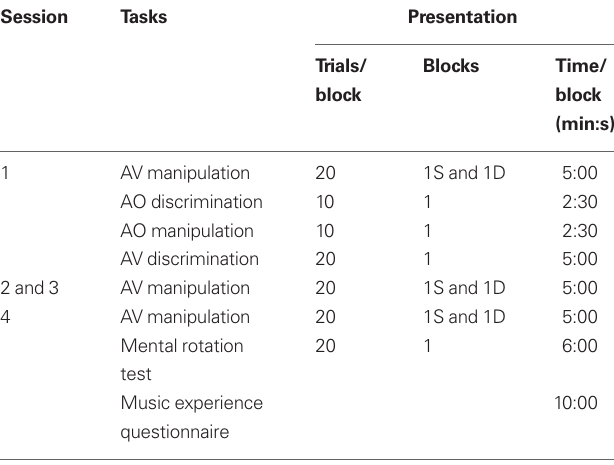
Table 7 | structure of the four melodic experimental sessions.